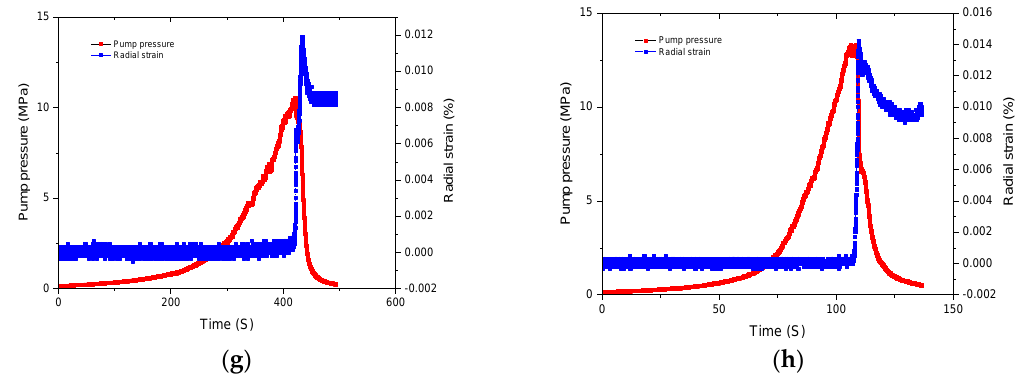
Figure 4. Hydraulic fracturing pressure and deformation curve of carbonate rocks: ( a ) C-2-7 slick water (0.02 mL/s); ( b ) C-2-8 slick water (0.07 mL/s); ( c ) C-2-3 guar gum (0.02 mL/s); ( d ) C-2-4 guar gum (0.07 mL/s); ( e ) C-1-1 cross-linked acid (0.02 mL/s); ( f ) C-1-2 cross-linked acid (0.07 mL/s); ( g ) C-1-7 gelled acid (0.02 mL/s); ( h ) C-1-8 gelled acid (0.07 mL/s).